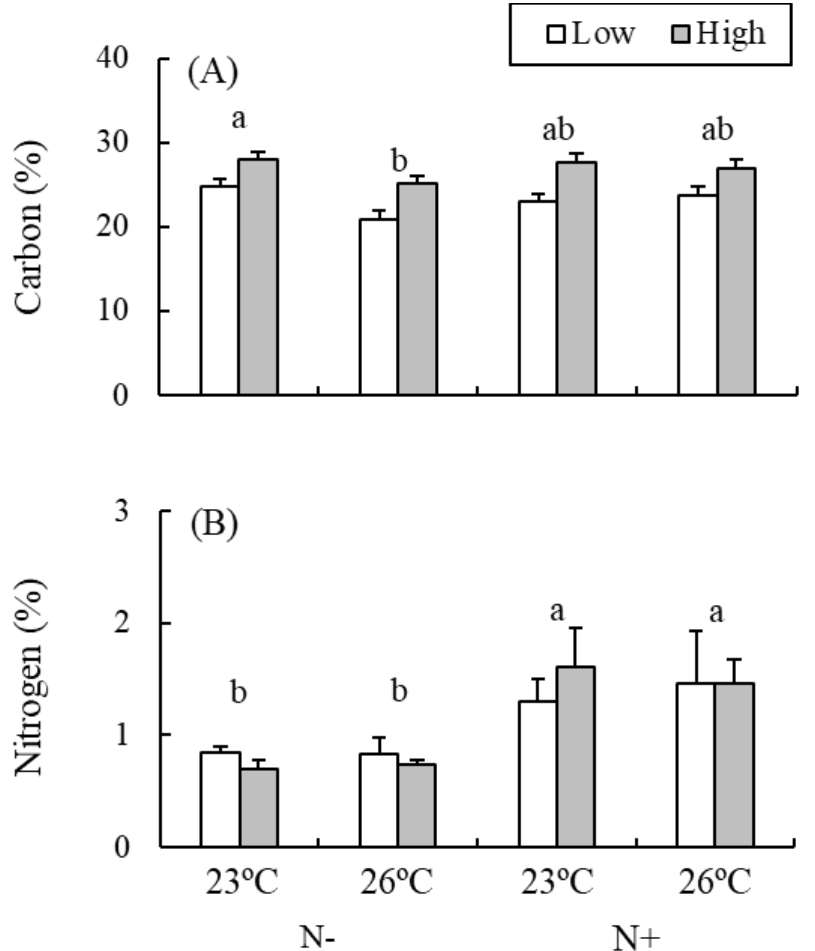
Figure 2. Carbon ( A ) and nitrogen ( B ) contents of Sargassum fusiforme shoots cultured in eight different treatments (mean + SD, n = 6). Low and High indicate low (30 µ mol photon m − 2 s − 1 ) and high (150 µ mol photon m − 2 s − 1 ) irradiance treatments, respectively. N+ and N- indicate nutrient enriched and non-enriched treatments, respectively. Different small letters indicate statistical significances among different treatments P < 0.05.